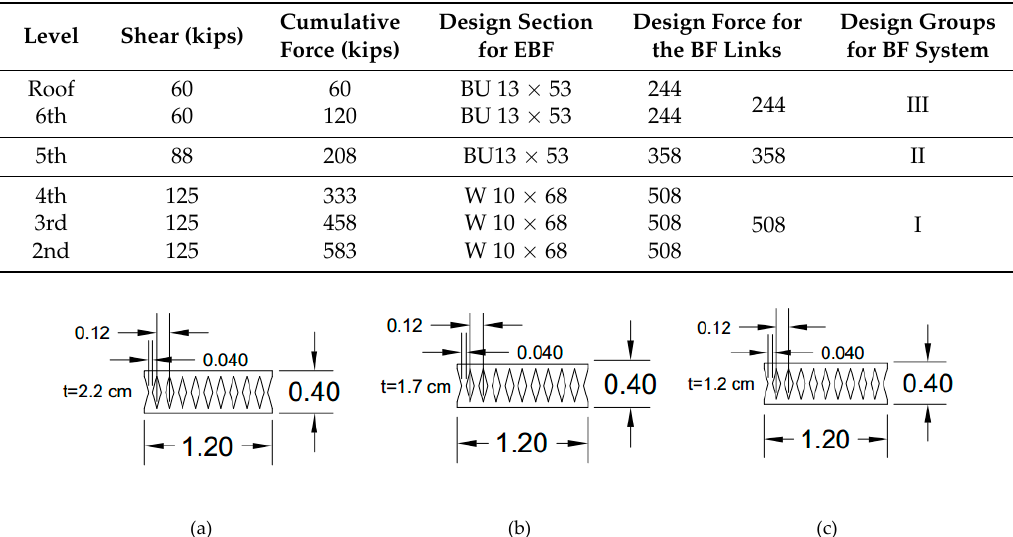
Table 1. Shear forces used for designing butterfly-shaped shear fuses.